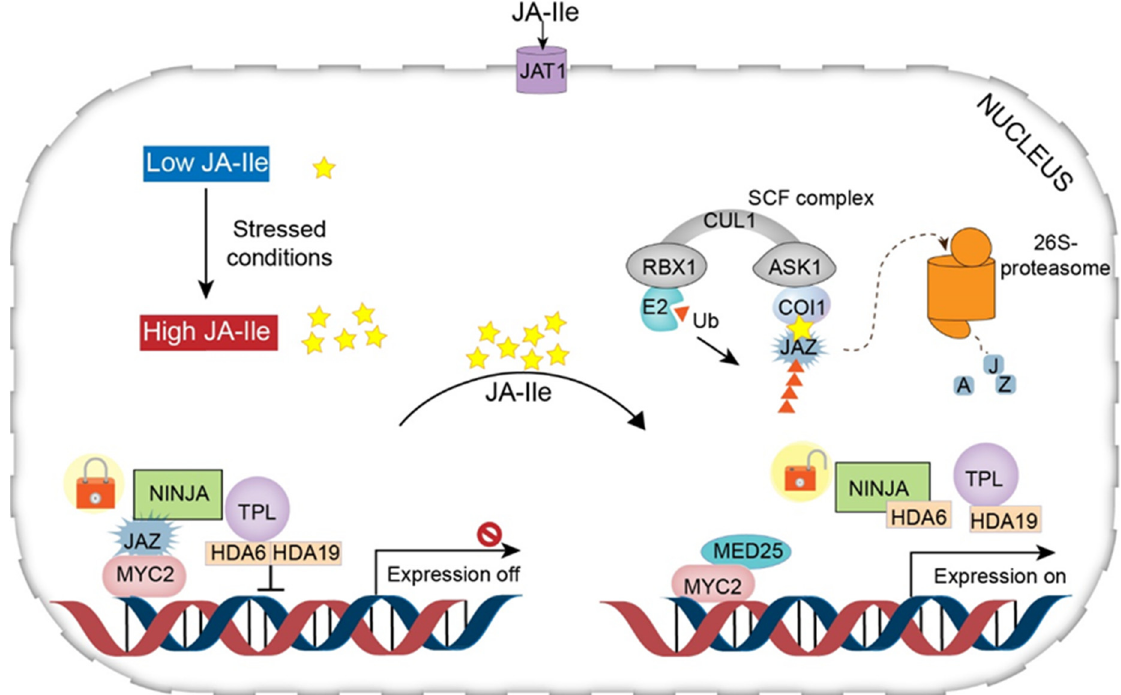
Figure 4. Working model of jasmonic acid signal transduction. Under normal conditions (without stimuli from abiotic stress), with a low level of JA-Ile, activation of the promoters of jasmonate-responsive genes is prevented, as the transcription factors are repressed by JAZ proteins. In this process, TPL and the adaptor protein NINJA are recruited to form an active transcriptional repression complex. Moreover, HDA6 and HDA19 are recruited to change the open complex to a closed one, thereby inhibiting JA responses. Under stress conditions, JA-Ile, which is epimerized from JA, shifts from low to high abundance, and is transported by JAT1 into the nucleus. Then, JA-Ile utilizes the interaction of JAZ with the F-box protein COI1 within the SCF complex, resulting in proteasomal degradation of JAZ. TFs are induced to bind to the G-box element, whereupon MED25 is recruited, activating the expression of jasmonate-responsive genes. Abbreviations: JA, jasmonic acid; JA-Ile, jasmonyl isoleucine; JAT1, jasmonic acid transfer protein 1; JAZ, jasmonate ZIM domain; NINJA, novel interactor of JAZ; TPL, topless; HDA6, HDA19, histone deacetylase 6, 19; Ub, ubiquitin; E2, ubiquitin-conjugating enzymes; RBX1, ring box 1; CUL1, cullin 1; ASK1, Arabidopsis SKP1 homolog 1; COI1, coronatine insensitive 1; MED25, mediator 25. (Redrawn based on [19]).